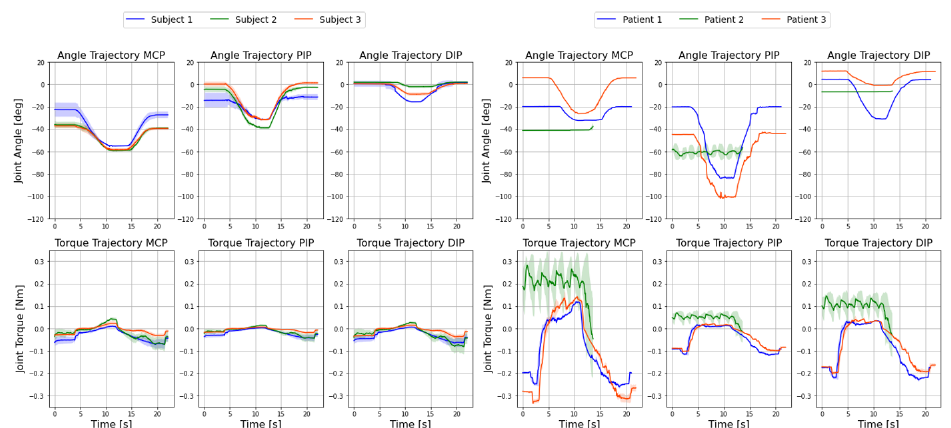
Figure 6. Comparative study between the three healthy subjects from Dickmann et al. [18] on the left and the three patients with CRPS on the right before therapy. The angle trajectories of MCP, PIP, and DIP joints are on the top row and the respective torque trajectories are on the bottom. The measurements shown correspond to the mean (line) ± standard deviations (shaded) of five individual